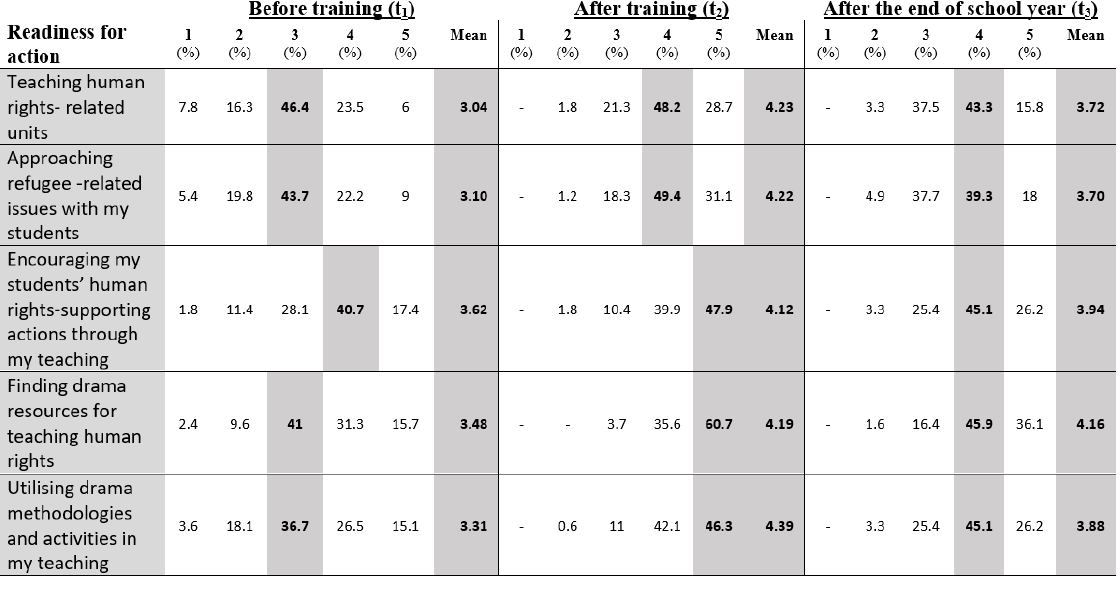
The ‘sense of readiness’ scale (percentages and